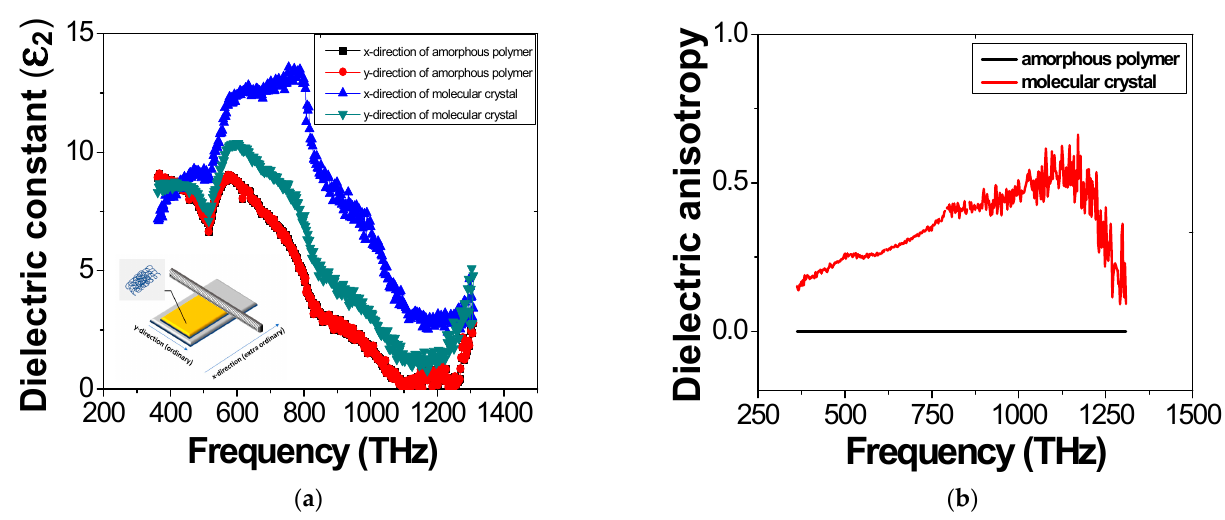
Figure 5. Measured dielectric constants of MEH-PPV film by SE: ( a ) imaginary value of dielectric constants with respect to the frequency and ( b ) dielectric anisotropy.